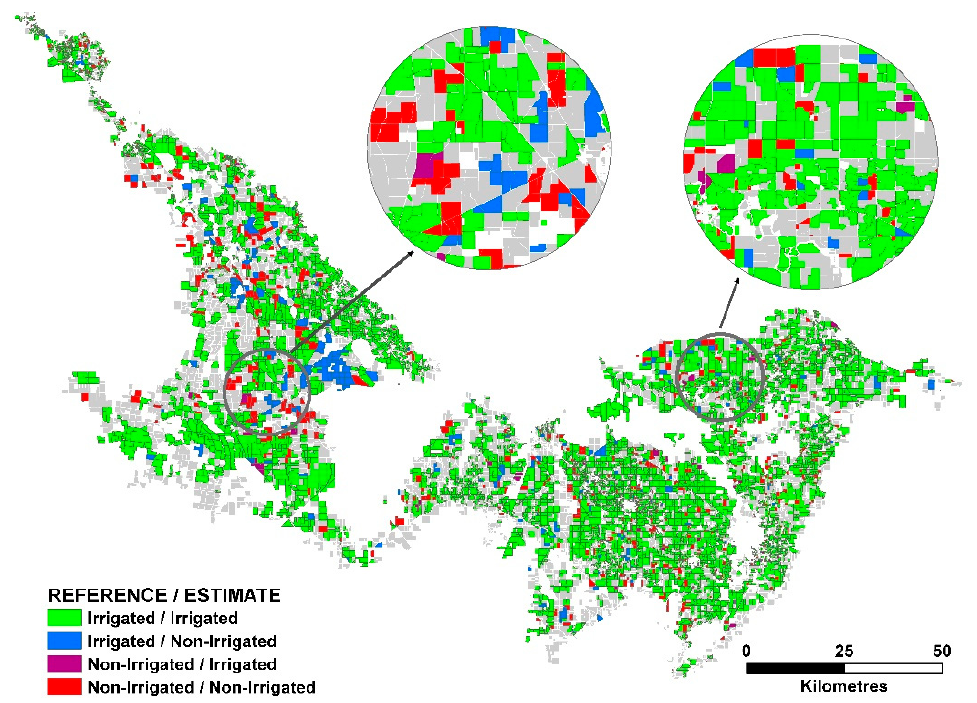
Figure 5. Map showing the accuracy assessment of farms.